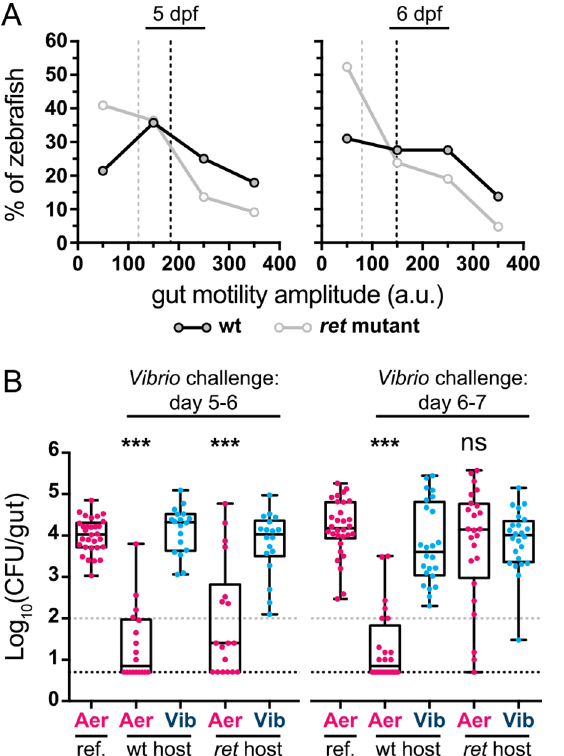
Fig 6. Intestinal motility and bacterial competition are altered in ret mutant zebrafish hosts. (A) Amplitudes of periodic contraction along the intestine for wild-type (wt) and ret mutant zebrafish at 5 and 6 dpf. Shown are histograms with the percent of individual larvae within different amplitude ranges. Vertical dashed lines indicate median amplitudes for respective curves. n = 28 (5 dpf, wt); n = 22 (5 dpf, ret ); n = 29 (6 dpf, wt); n = 21 (6 dpf, ret ). (B) GF wild-type and ret heterozygous hosts (wt) were raised together with ret homozygous mutant hosts ( ret ) and colonized at 4 dpf with Aeromonas . At 5 (left) or 6 (right) dpf Vibrio